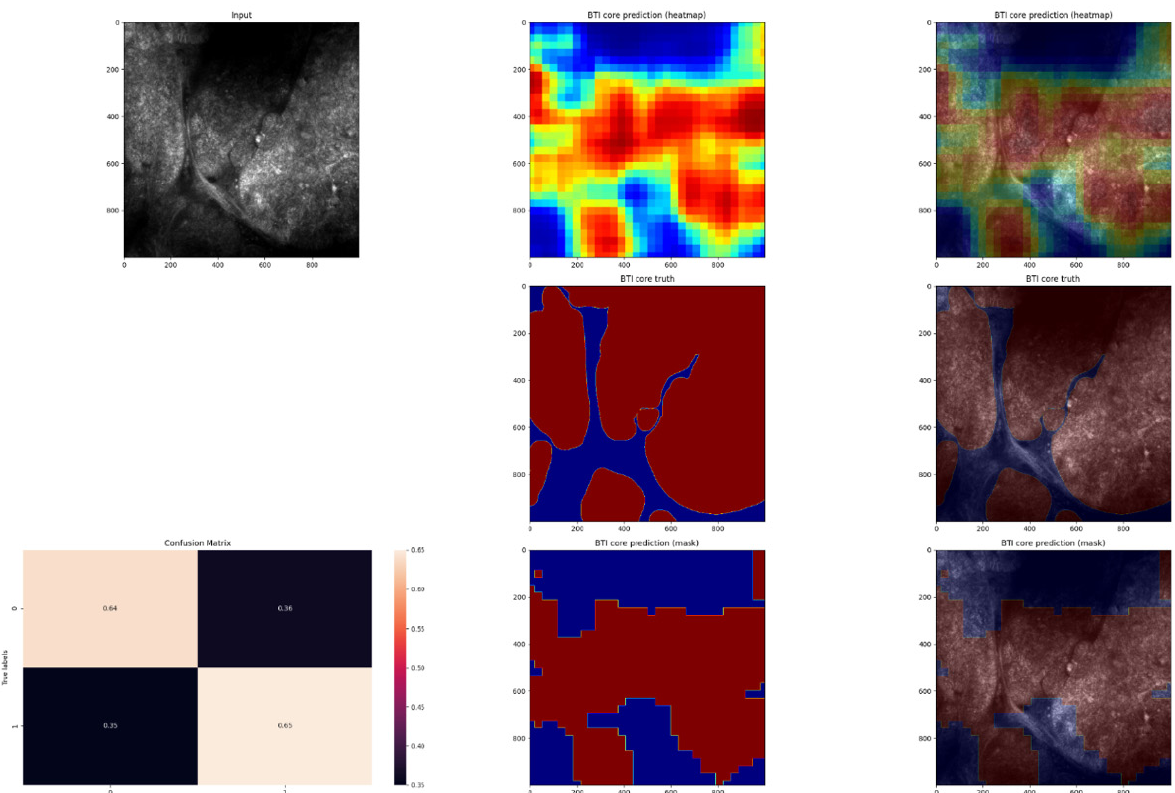
Figure 7. Third example of an in vivo RCM image of a BCC, with cancerous regions manually annotated and automated predictions. An image of the predicted heatmap can also be seen in the image. Jet is a colormap that ranges from blue to red, where the former represents SCC and the latter, non-SCC. Using the methodology described in the Materials and Methods section, image shows the prediction mask generated from the heatmap. Additionally, a normalized confusion matrix is shown for each row. The class that is not SCC is represented by 0 represents, and 1 represents the class that is SCC. As we can see, this is an average-performing example. This is another better-performing example; the majority of the cancerous regions were predicted correctly.